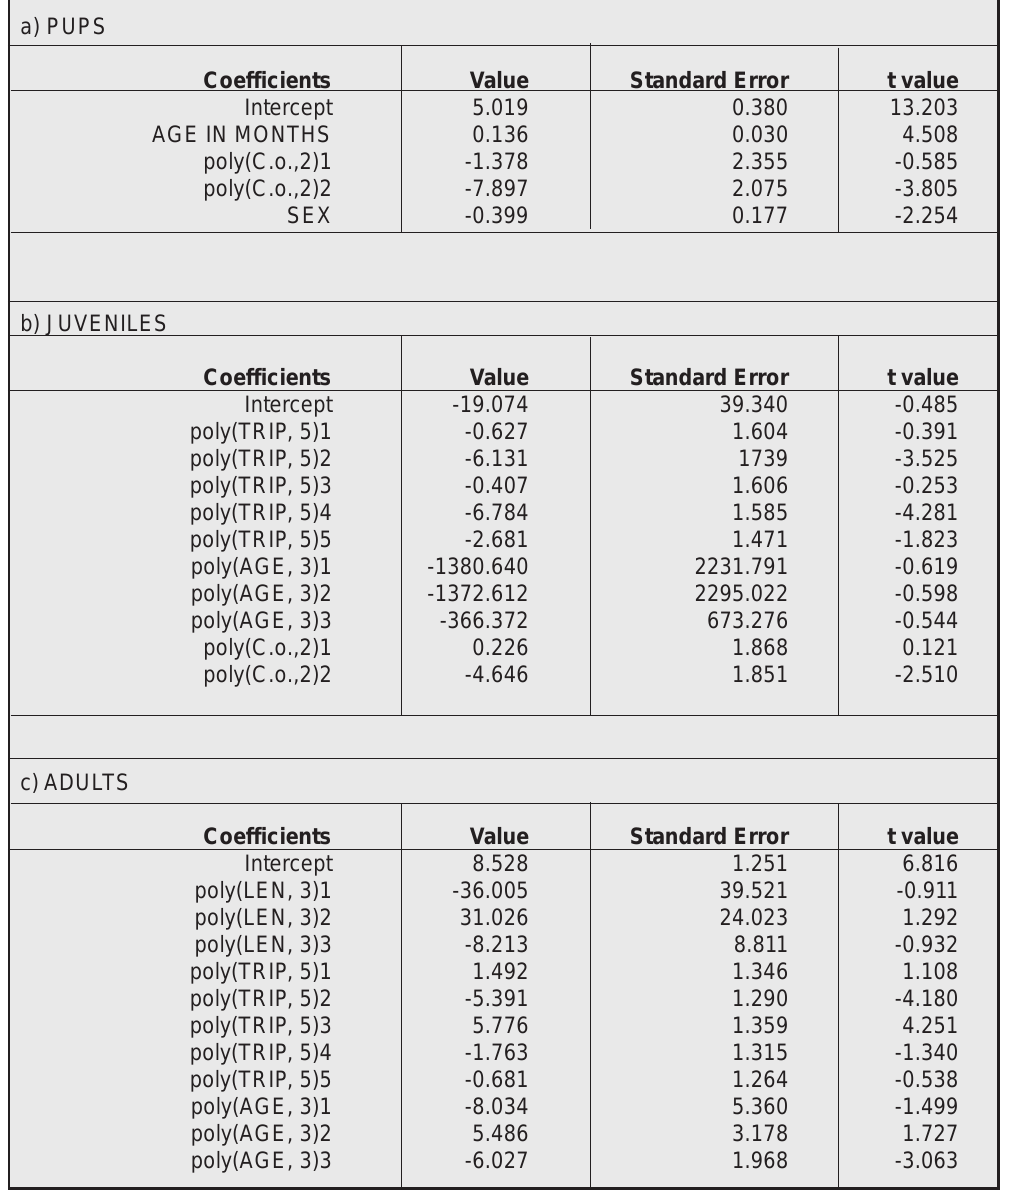
Table 6. Analysis of deviance of log Pseudoterranova decipiens abundance in juveniles. Terms in italics not retained in final model. The preceder “poly” defines the term as a polynomial (term,degrees of freedom). The C.o. term denotes log Contracaecum osculatum abundance.